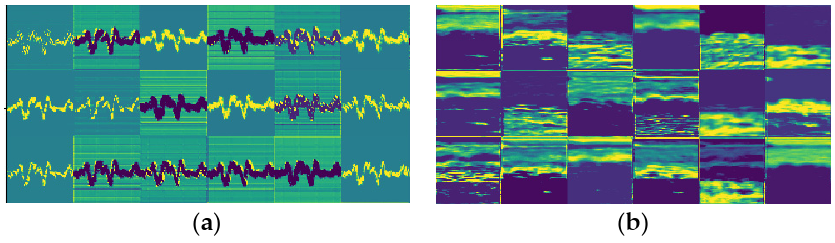
Figure 3. Time and frequency spectrum partly feature images from arc sound using CNN. ( a ) Time domain and ( b ) frequency spectrum.